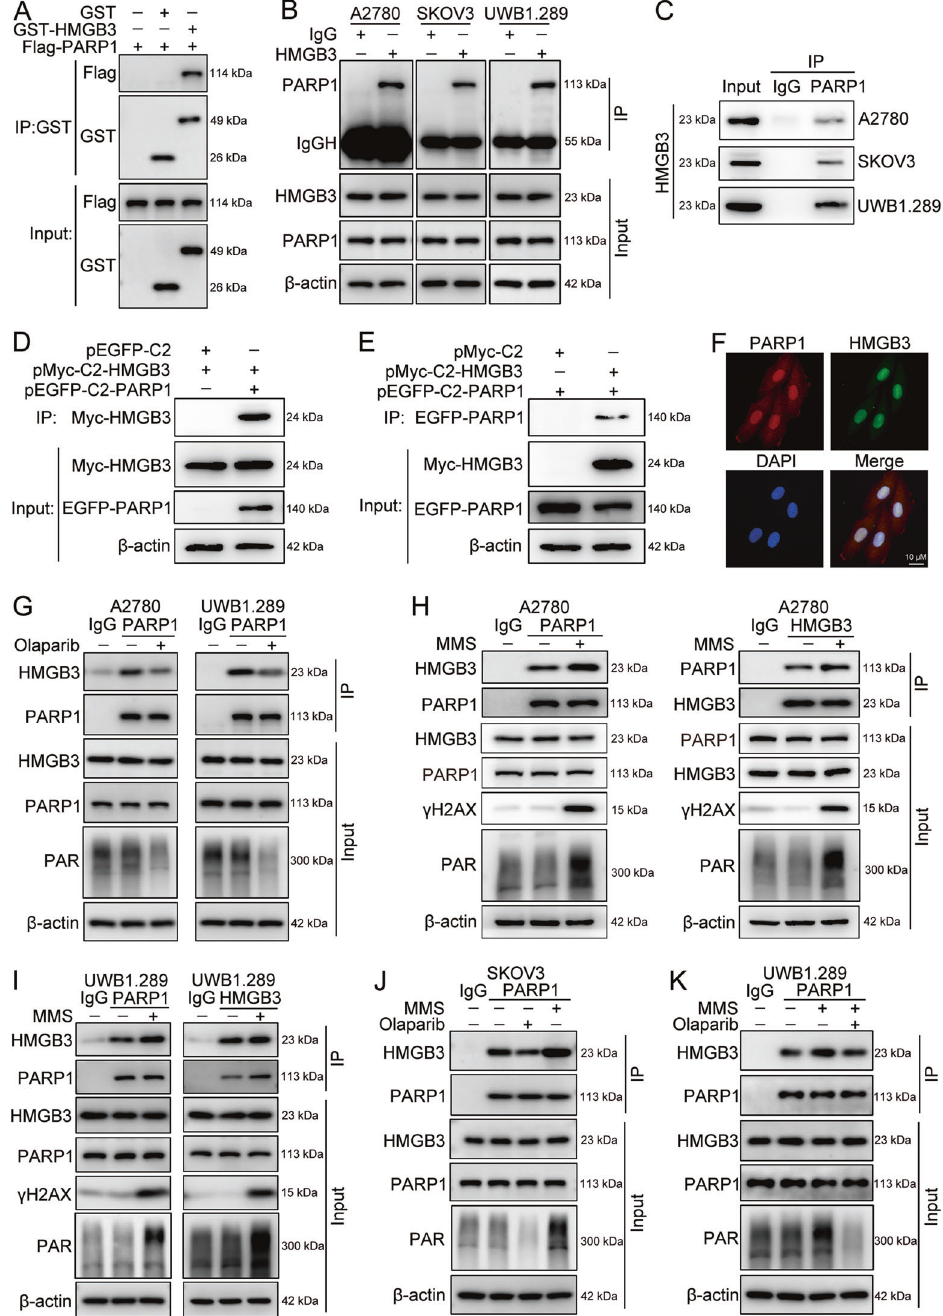
Fig. 4 HMGB3 directly interacts with PARP1. A GST pull-down assay was used to verify the direct interaction between HMGB3 and PARP1. B , C Co-IP was performed to verify the endogenous interaction between HMGB3 and PARP1 in A2780, SKOV3, and UWB1.289 cells. D , E HEK293T cells were co-transfected with pMyc-C2-HMGB3 and pEGFP-C2-PARP1 plasmids for 48 h. Western blot analysis of exogenous EGFP-PARP1 or Myc-HMGB3 proteins co-immunoprecipitated (Co-IPed) with anti-Myc or anti-GFP antibody, respectively. F Double immuno fl uorescence staining showed the intracellular localization of HMGB3 (green) and PARP1 (red) in UWB1.289 cells. The nucleus was stained with DAPI (blue). Scale bar: 10 µm. G A2780 and UWB1.289 cells were treated with olaparib (A2780, 4 µM; UWB1.289, 2 µM) for 12 h. Co- IP was performed using anti-PARP1 antibody or mouse IgG isotype control. Western blot was used to detect HMGB3 and PARP1 from precipitated proteins. HMGB3, PARP1, PAR, and β -actin were detected among the input proteins. H , I A2780 and UWB1.289 cells were treated with 4 mM MMS for 20 min. Co-IP was performed using an anti-PARP1 antibody, anti-HMGB3 antibody, or IgG isotype control. Western blot was used to detect PARP1 and HMGB3 among the precipitated proteins. PARP1, HMGB3, γ H2AX, PAR, and β -actin were detected among the input proteins. J SKOV3 cells were treated with olaparib (10 µM) for 12 h or MMS (4 mM) for 20 min. Co-IP and western blot were performed to determine the interaction between HMGB3 and PARP1. K UWB1.289 cells were treated with olaparib (2 µM) for 4 h prior to incubation with MMS (4 mM) for 20 min. Co-IP and western blot were performed to determine the interaction between HMGB3 and PARP1. ( n = 3). Quanti fi cation of the protein levels can be found in Fig. S4.